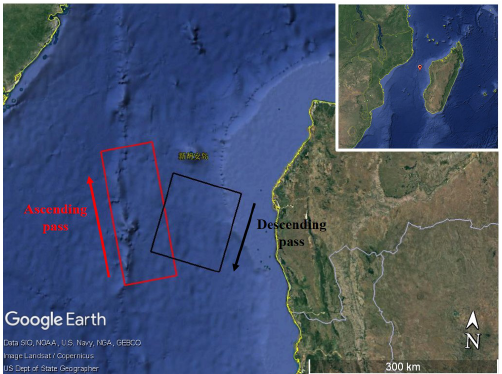
Figure 3. Spatial geographic location of the actual SAR data.